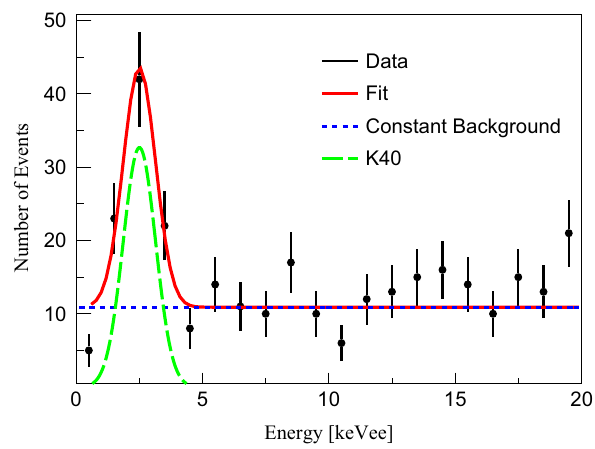
Fig. 9 40 K 3.2 keV spectrum in the NEO-2 crystal tagged by the 1460 keV γ s in the surrounding NaI(Tl) crystals